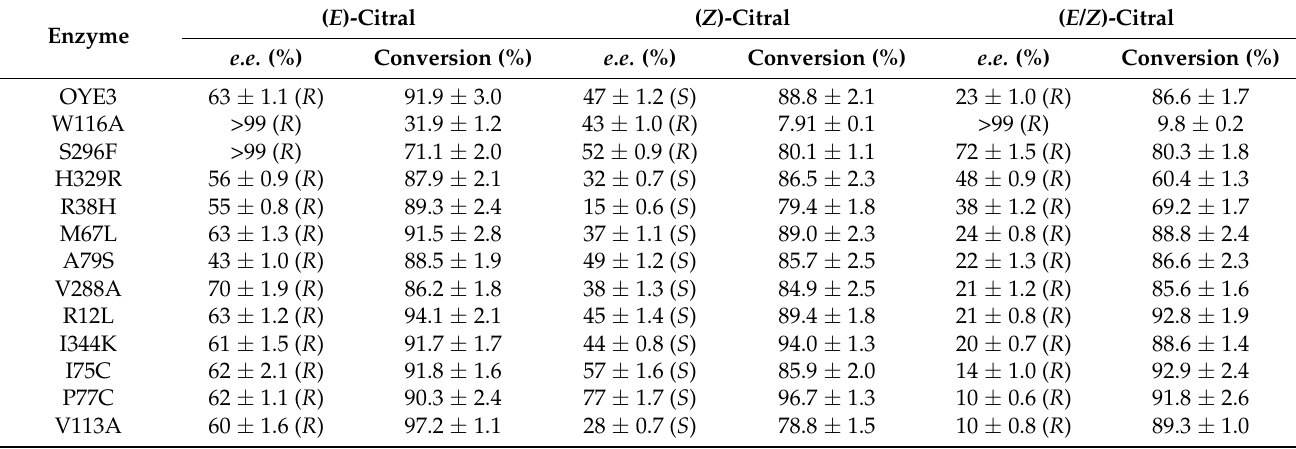
Table 1. The catalytic performances of OYE3 and its variants with single substitution at putative key residues 1 . ( E Enzyme